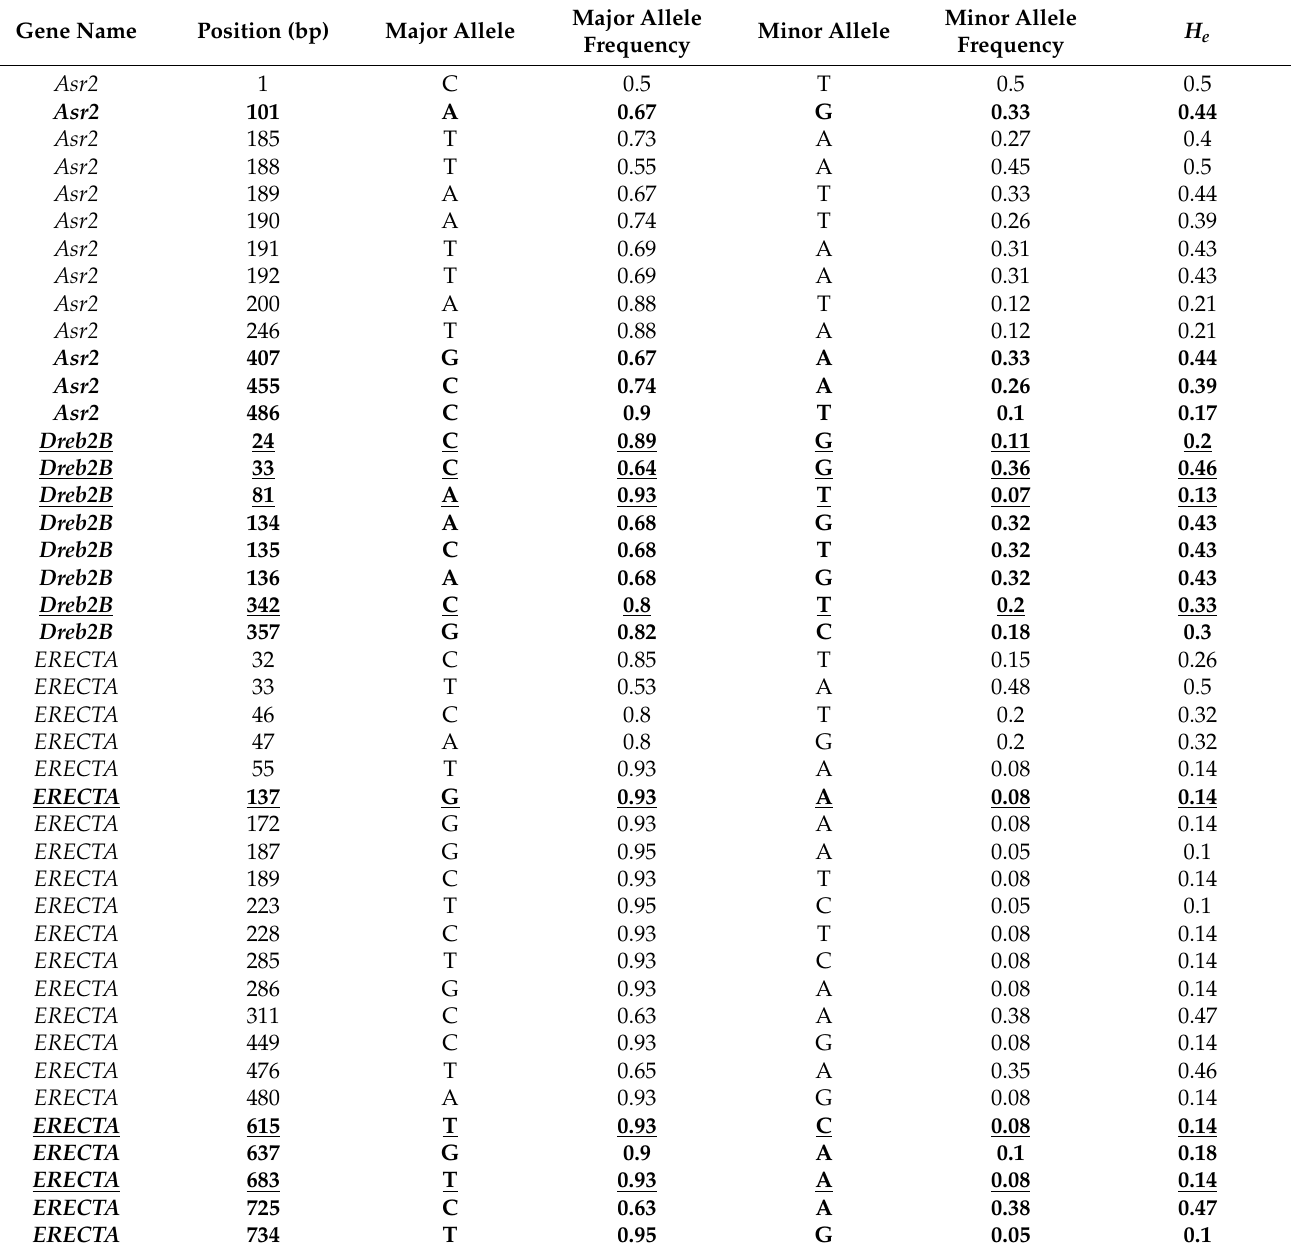
Table 1. SNP marker polymorphisms at Asr2 , Dreb2B , and ERECTA -encoding drought candidate genes in tepary bean s.l. SNPs in coding regions are marked in bold, and non-synonymous variants are in bold and